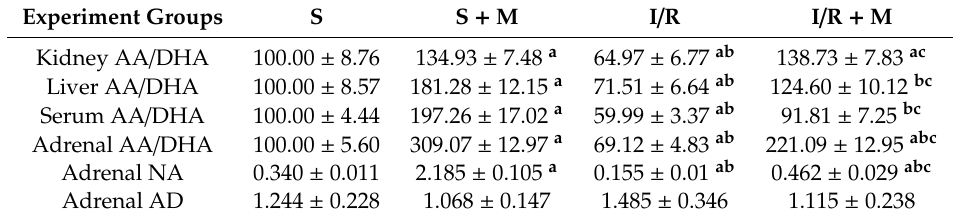
Table 3. The ascorbic / dehydroascorbic acid ratio (AA / DHA, % of sham) in serum, liver, adrenal gland, and kidney, as well as adrenal noradrenaline (NA) and adrenaline (AD) content ( µ g / mg tissue). Group categories abbreviations: S—sham operated rat group; S + M—sham operated + meldonium rat